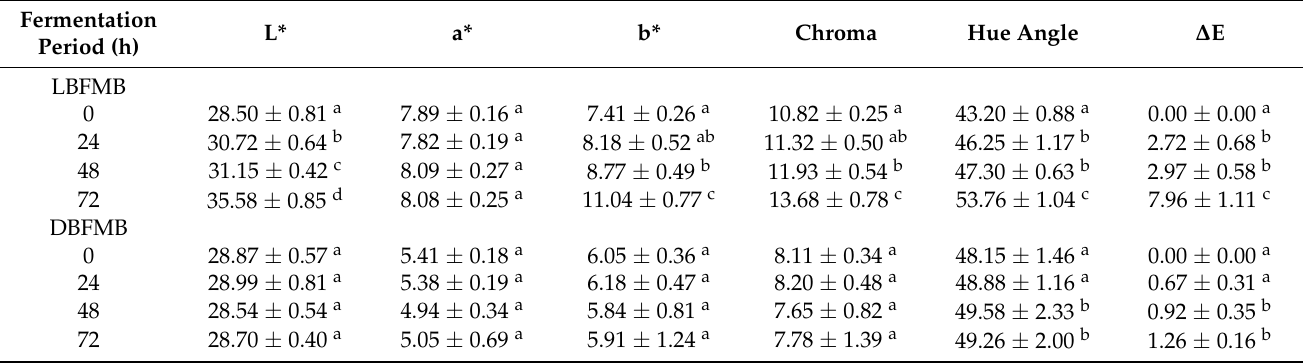
Table 4. Influence of spontaneous fermentation on the colour attributes of finger millet biscuits.